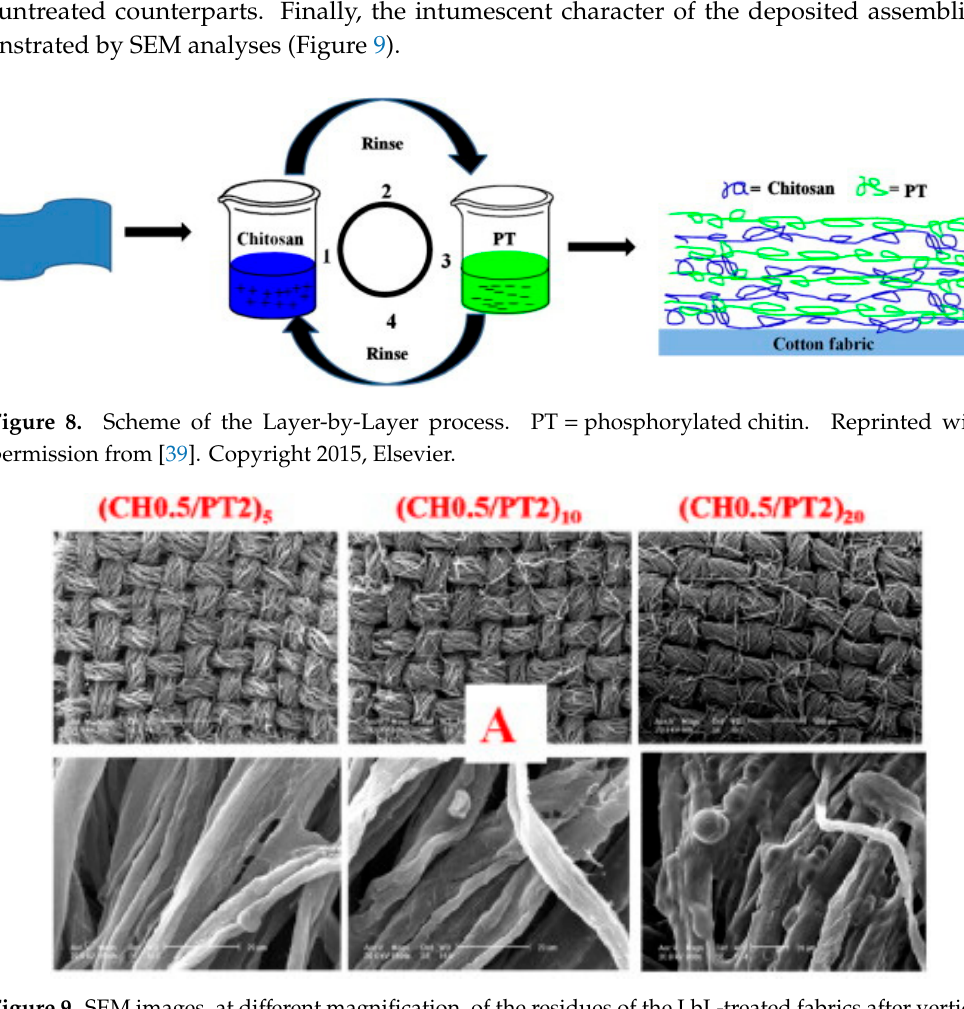
Figure 9. SEM images, at different magnification, of the residues of the LbL-treated fabrics after vertical flame spread tests. 5, 10 and 20 correspond to the number of deposited bi-layers. CH = chitosan; PT = phosphorylated chitin; 0.5 and 2 are the wt. % concentrations of the biomacromolecules in the dipping baths. Reprinted with permission from [39]. Copyright 2015, Elsevier.